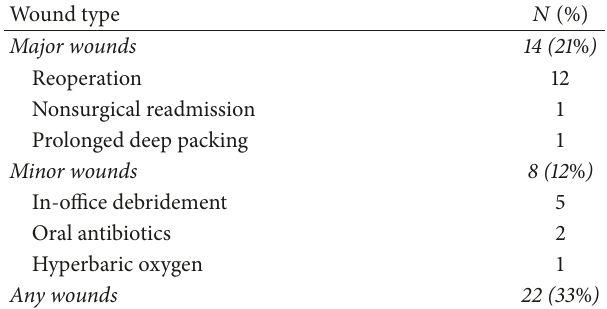
Table 3: Wound complications in study